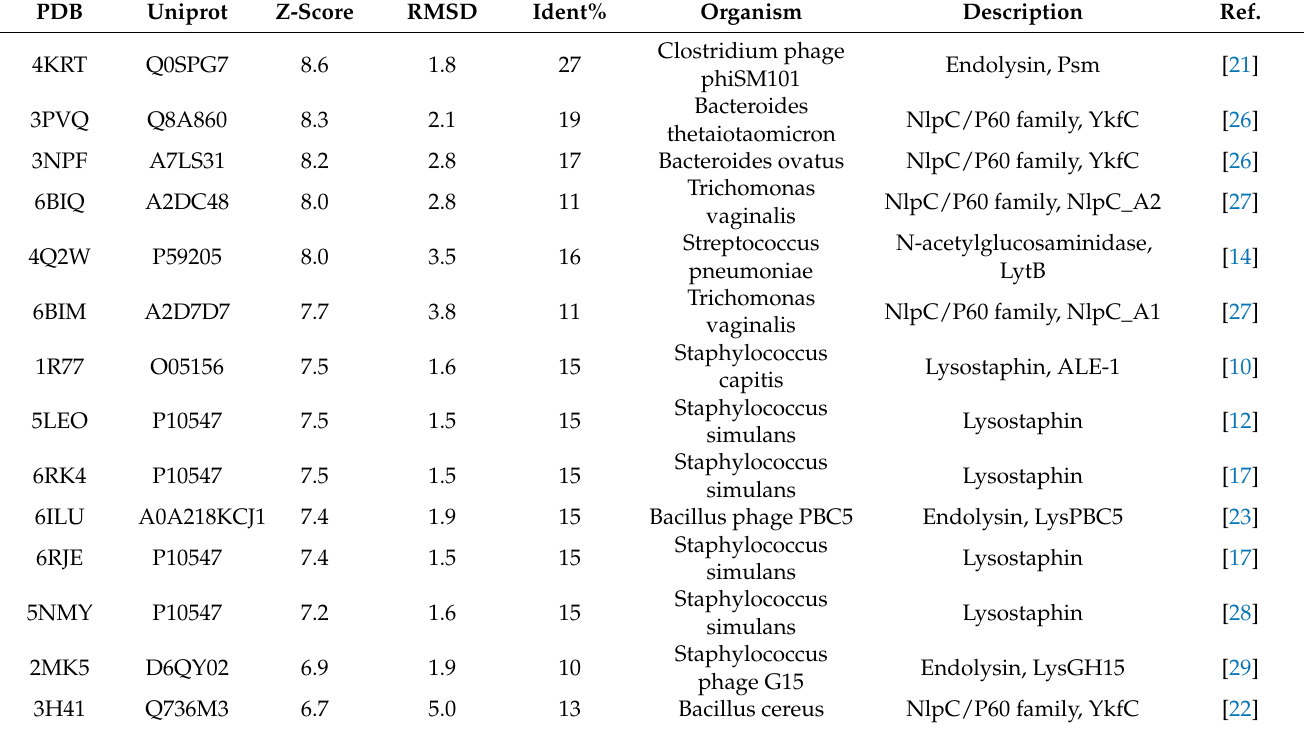
Table 3. Structure similarity analysis of CpAcp SH3b6 using Dali server. The proteins are ranked according to the structural similarity score (Z-score). Organism Description